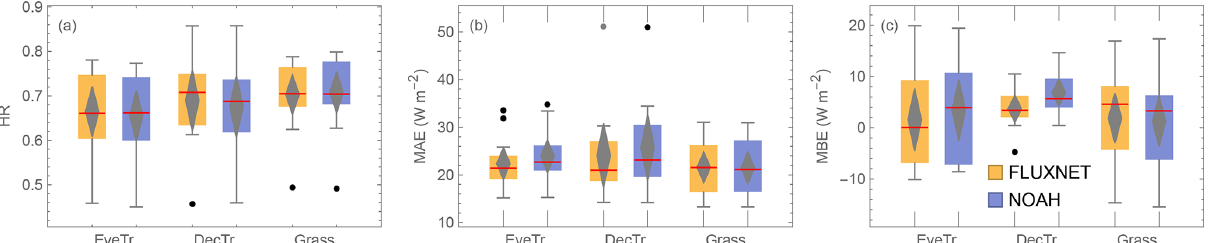
Figure 14. Simulated Q E using two sets of parameters (colour, FLUXNET – Table C3, NOAH – Table A1 assigned based on Table 3 PFT class) at 38 sites (boxplots, as Fig. 9, subdivided into three land cover classes: EveTr, DecTr and Grass) evaluated for 2 years with observed 30 or 60min fluxes using three metrics (Sect. 5.1): (a) HR, (b) MAE and (c)